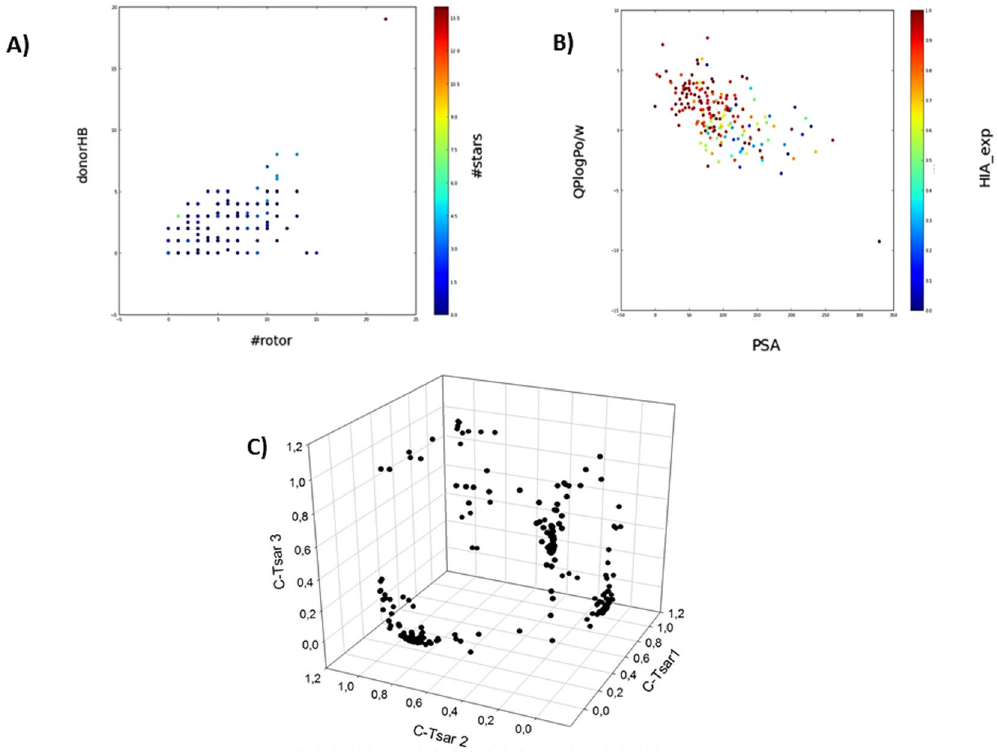
Figure 4. Physicochemical and structural representation of the HIA dataset. ( A ) Dispersion of the compounds regarding hydrogen bond donors and rotatable bonds. Color is defined by stars, a parameter related to physical- chemical properties of commercially available drugs. ( B ) Dispersion of the dataset taking into account logP values and Polar Surface Area (PSA). Color is defined by HIA experimental values. ( C ) Structural diversity represented as a 3D dispersion of compounds using CODES